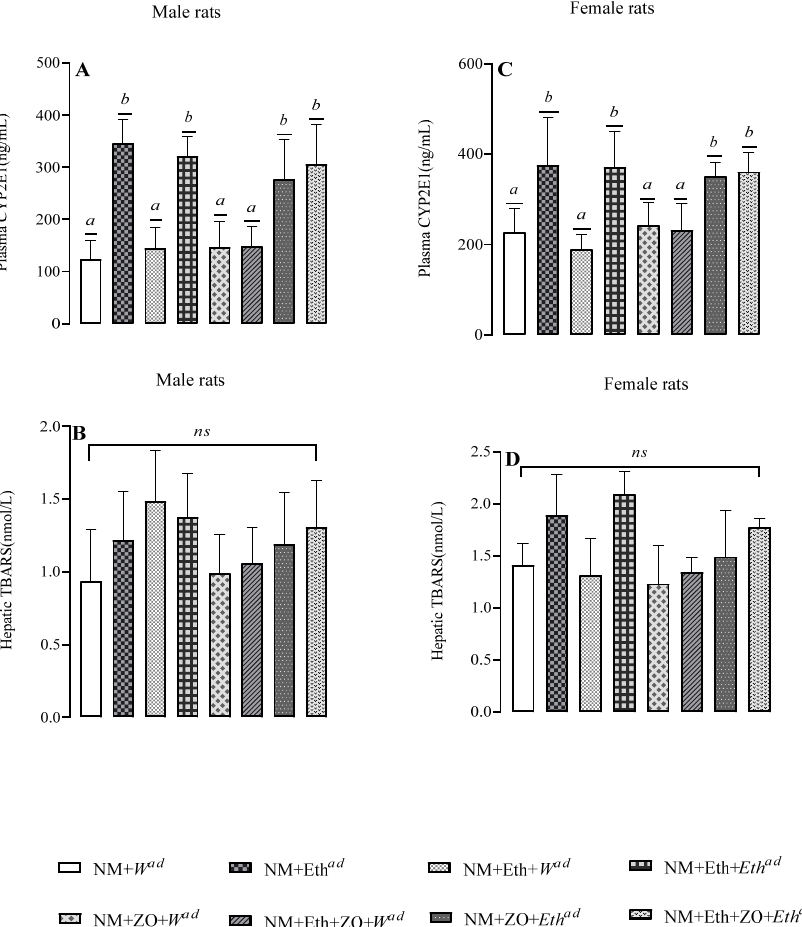
Figure 6. Effect of neonatal orally administered zingerone on plasma CYP2E1 ( A , C ) concentration and hepatic TBARS ( B , D ) concentrations in male ( A , B ) and female (D&D) rats drinking alcohol in adulthood. Data are presented as mean ± standard deviation. ( p < 0.05). a,b = Bars means with differ ‐ ent letters are significantly different at p < 0.05 Control (NM + W ad )—neonatally gavaged with nutri ‐ tive milk (NM) and received plain drinking water ( W ad ) at stage III; late single hit (NM + Eth ad )— neonatally gavaged with NM and received ethanol ( Eth ad ) solution at stage III; early single hit (NM + Eth + W ad )—neonatally gavaged with ethanol in nutritive milk and received plain drinking water